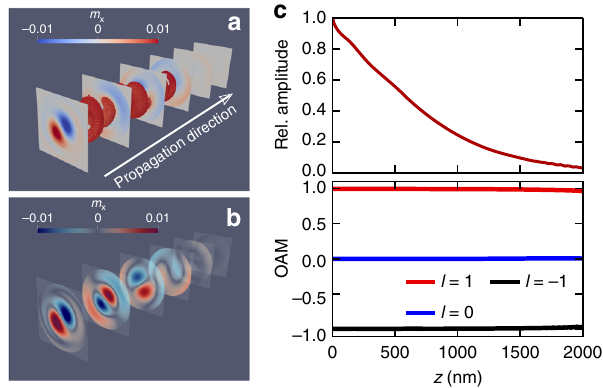
Fig. 2 Spiraling spin wave propagating along a cylindrical micro-scale waveguide of the insulting magnet yttrium iron garnet. a Snapshot of the magnon beams after 2 ns for the x -component of the triggered magnetization. b Vortex con fi guration of the excitation modes along the waveguide. c The z -resolved amplitude and the orbital angular momentum of the spin waves. In a – c , the spin waves are excited locally at one end of the waveguide by a twisted radio frequency (rf) magnetic fi eld having the peak amplitude B max = 10 mT, and a frequency ω B = 5 GHz. For the time evolution of m x at the transversal slice z = 1 μ m see Supplementary Movie